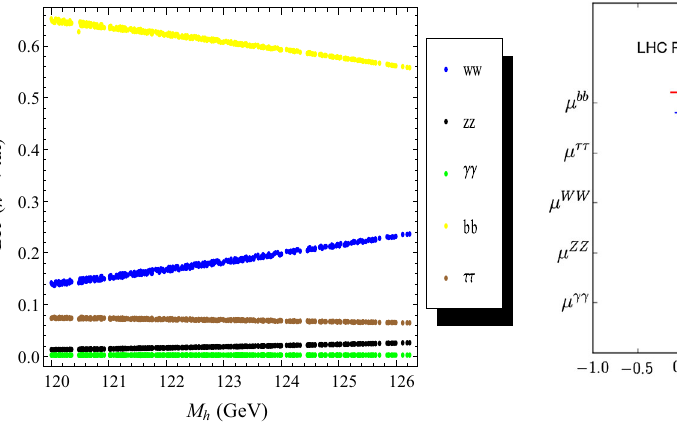
1 σ (thicklines)and2 σ (thinlines)intervals.Thecombinedresultsshow a remarkable agreement with the SM prediction (normalized to μ = 1)